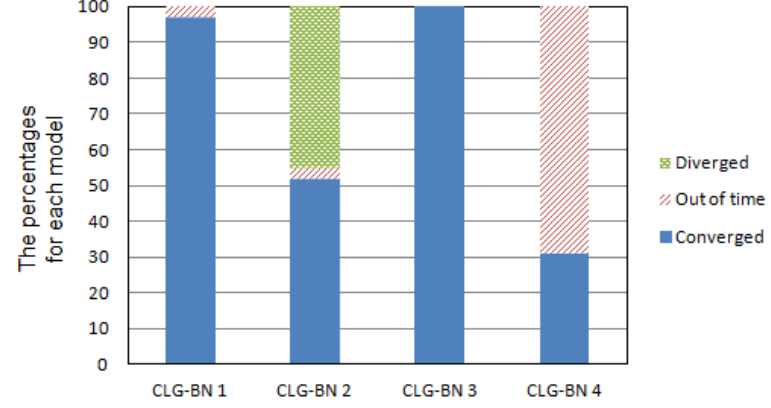
Figure 6. Percentages for each model case when the algorithm converged, diverged and ran out of